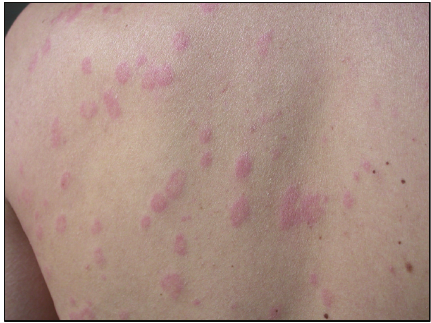
Figure 4: Pink-to-red edematous lesions, that have pale centers localized on the back of a patient a ff ected by